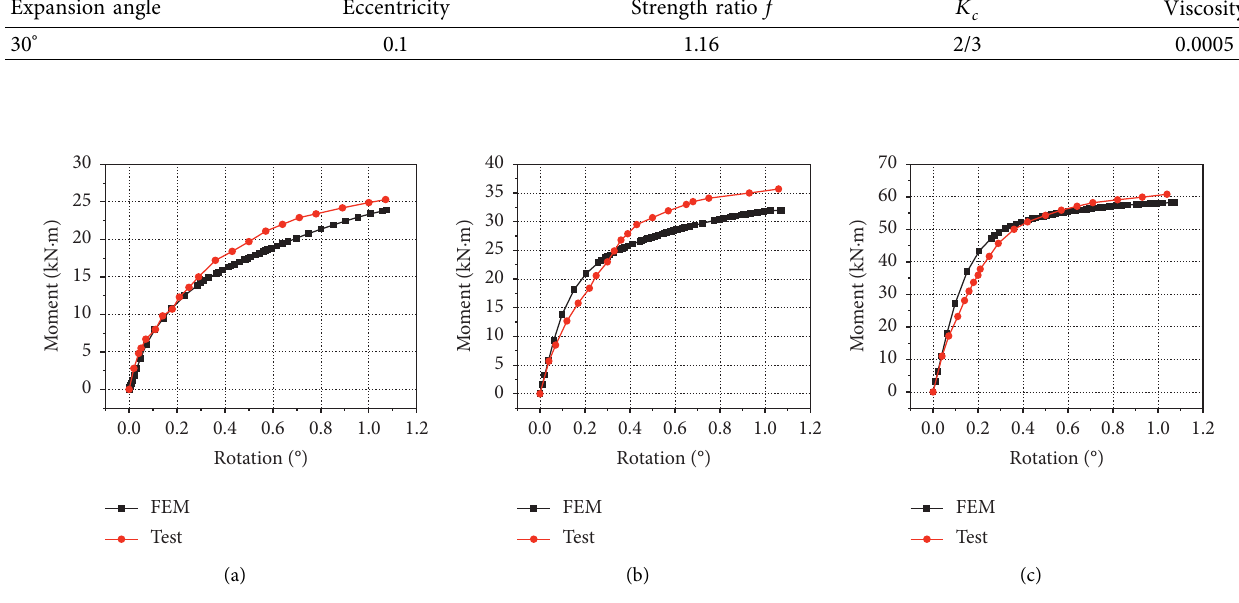
Figure 11: Moment-rotation curves: (a) CB-1, (b) CB-2, and (c)